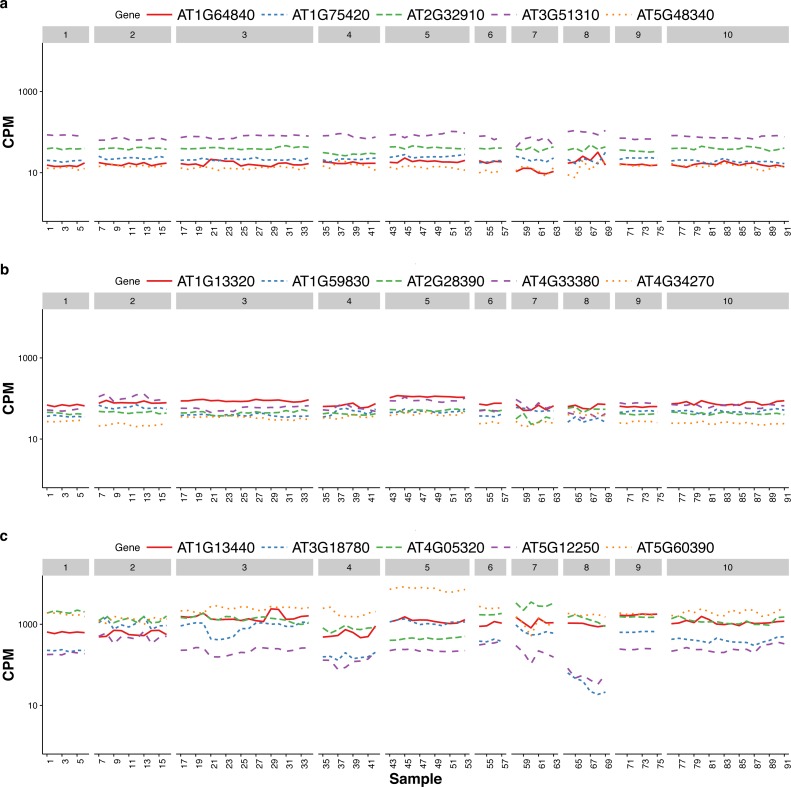
Expression profiles of 15 genes—as measured by RNA-Seq CPM—across 91 samples in the multi-tissue group.The 15 genes include (from top to bottom) (A) five stably expressed genes (randomly selected out of the top 100) identified from the multi-tissue group RNA-Seq data using the total variance measure \documentclass[12pt]{minimal}
\usepackage{amsmath}
\usepackage{wasysym} 
\usepackage{amsfonts} 
\usepackage{amssymb} 
\usepackage{amsbsy}
\usepackage{upgreek}
\usepackage{mathrsfs}
\setlength{\oddsidemargin}{-69pt}
\begin{document}
}{}${\hat {\sigma }}^{2}$\end{document}σ ˆ2, (B) five stably expressed identified by Czechowski et al. (2005) according to the CV measure from a developmental series of microarray experiments, and (C) five traditional house-keeping genes (HKG) discussed in Czechowski et al. (2005).